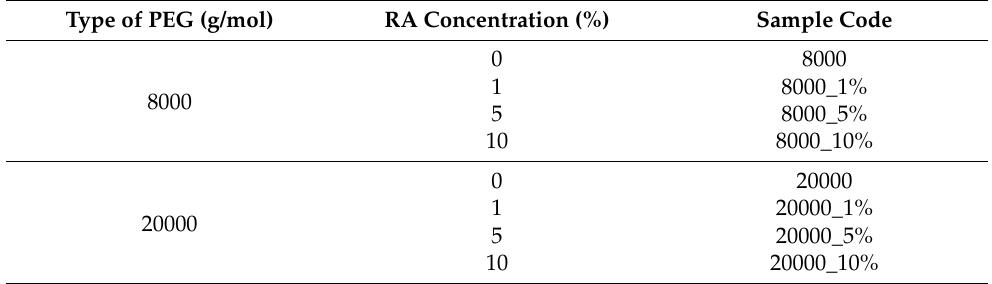
Table 1. Summary of the samples obtained and their codes. Type of PEG